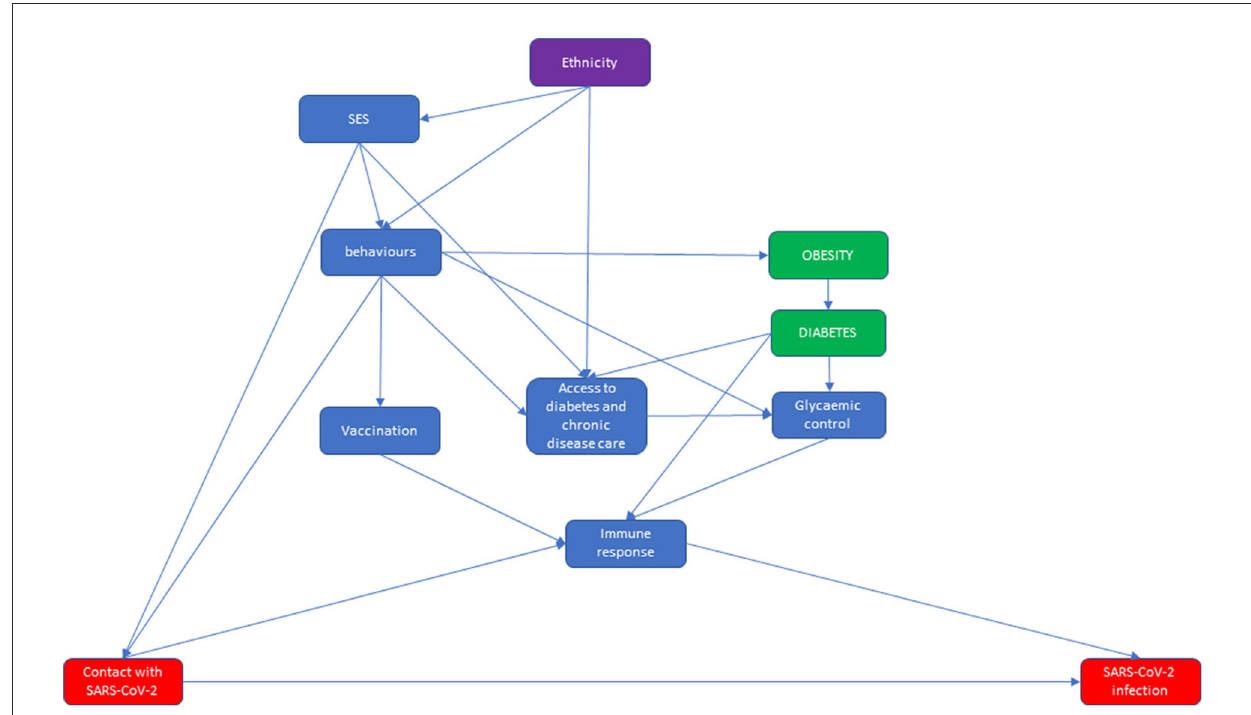
FIGURE1 Direct acyclic graph (DAG) of the relationship between ethnicity and diabetes from contact with SARS-CoV-2 to SARS-CoV-2 infection, in which the effect modifier is ethnicity, the exposures are obesity and diabetes, and the outcome is SARS-CoV-2 infection.